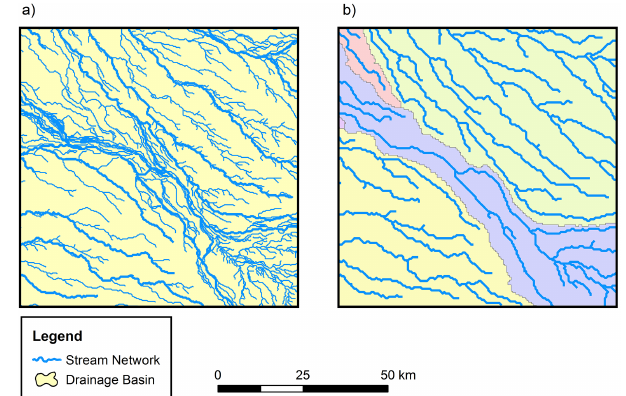
Figure 9. The stream network and drainage basins delineated by (a) this study and (b) supplied by the HydroSHEDS database for the area shown in the inset map of Fig. 4. By recognising distribu- tary drainage connections, one drainage basin is delineated for these rivers draining into the Gulf of Carpentaria, while the HydroSHEDS database delineates multiple